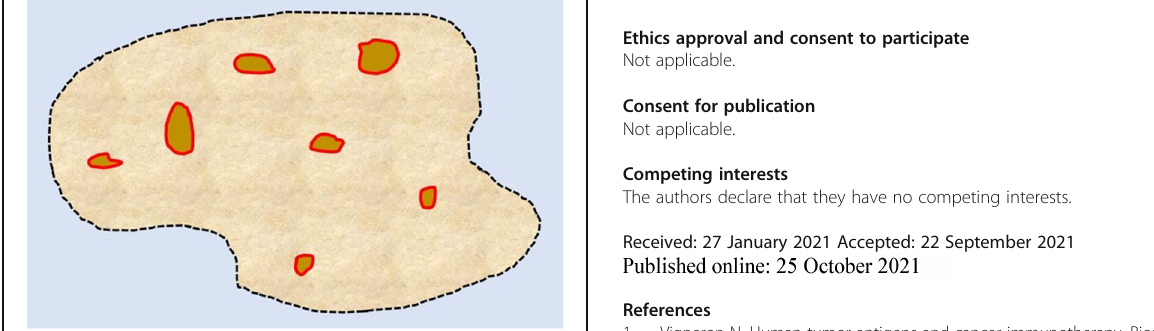
Fig. 15 A diagram depicting expression of PD-L1 positive tumor infiltrating immune cells (marked by red border) in an area of tumor cells (marked by black dotted line). The proportion of tumor area occupied by PD-L1-positive immune cells of any intensity determines the immune cell (IC)